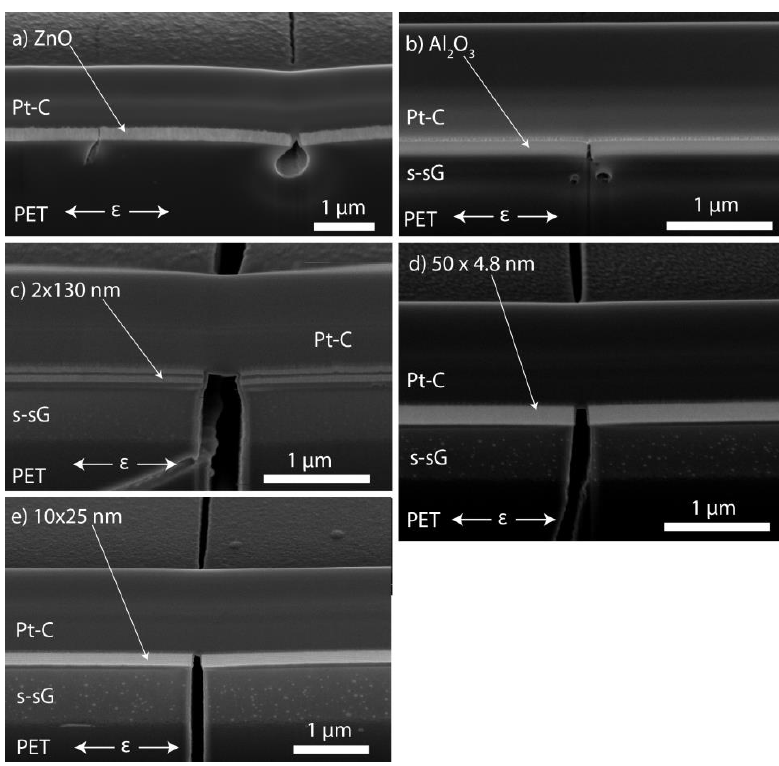
Figure 5. SEM images of FIB cut cross-sections (52° angle) for all the samples; ( a ) ZnO, ( b ) Al 2 O 3 , ( c ) 2 × 130 nm nanolaminate, ( d ) 50 × 4.8 nm nanolaminate, ( e ) 10 × 25 nm nanolaminate. (s-sG = sub-surface growth, Pt-C = local protection material deposited by FIB for FIB cut) showing through-thickness through substrate cracks during tensile